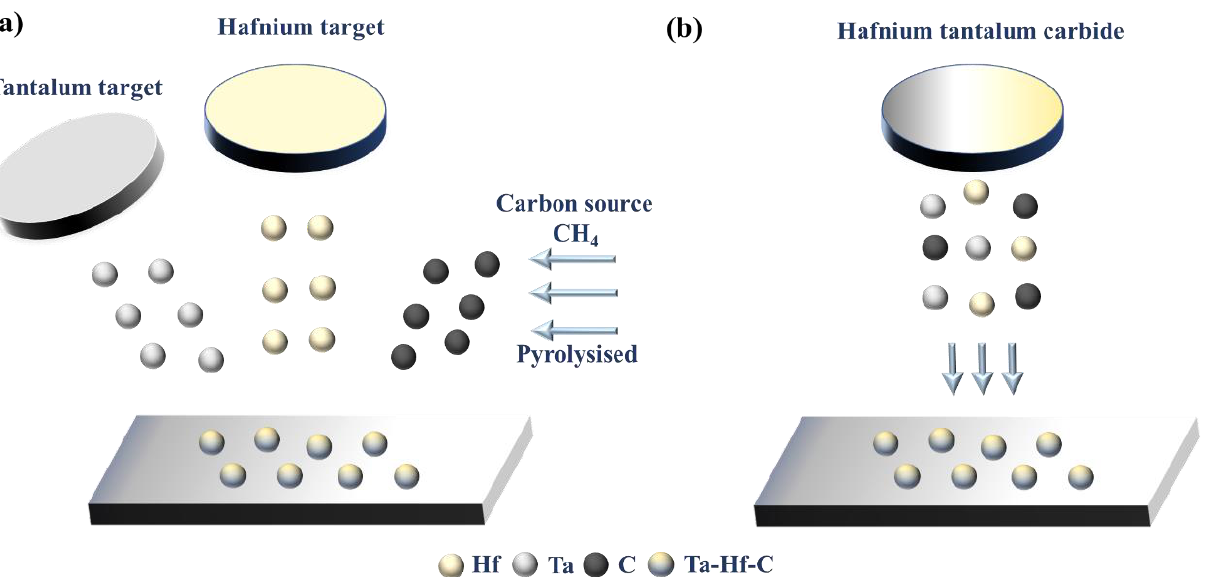
(EDS) results of TaC-HfC target show that the uniform mixing of Hf and Ta elements forms the composite with a small amount of mutual diffusion. The content of Hf is about 27 mol%, in all targets.